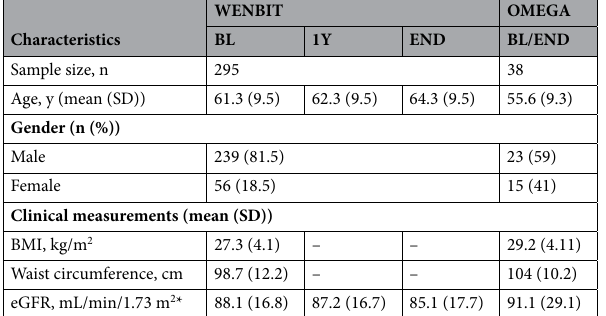
Table 1. Characteristics of participants of WENBIT and OMEGA cohorts. *eGFR was calculated using the MDRD study equation as 186 × [serum creatinine (mg/dl)] −1.154 × (age) −0.203 × (0.742 if